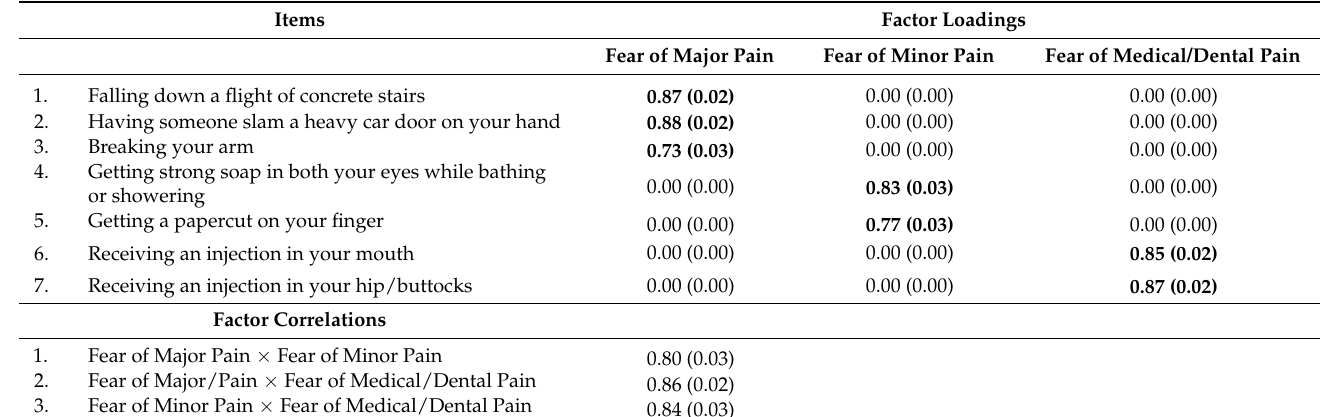
Table 3. Factor model of three-factor IA-FPQ-7 in Indigenous Australian.